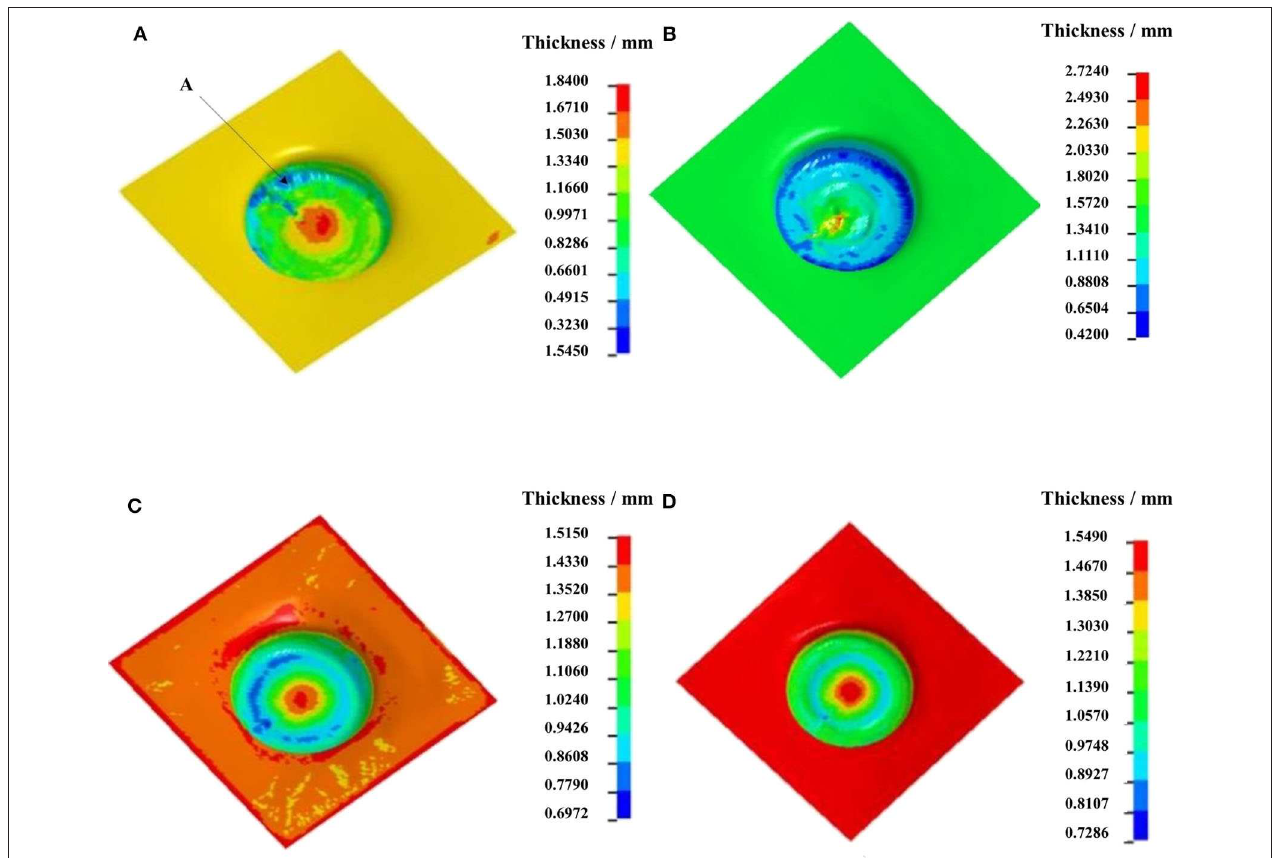
FIGURE 7 | Wall thickness contours at different temperatures: (A) 25 ◦ C; (B) 150 ◦ C; (C) 200 ◦ C; (D) 250 ◦